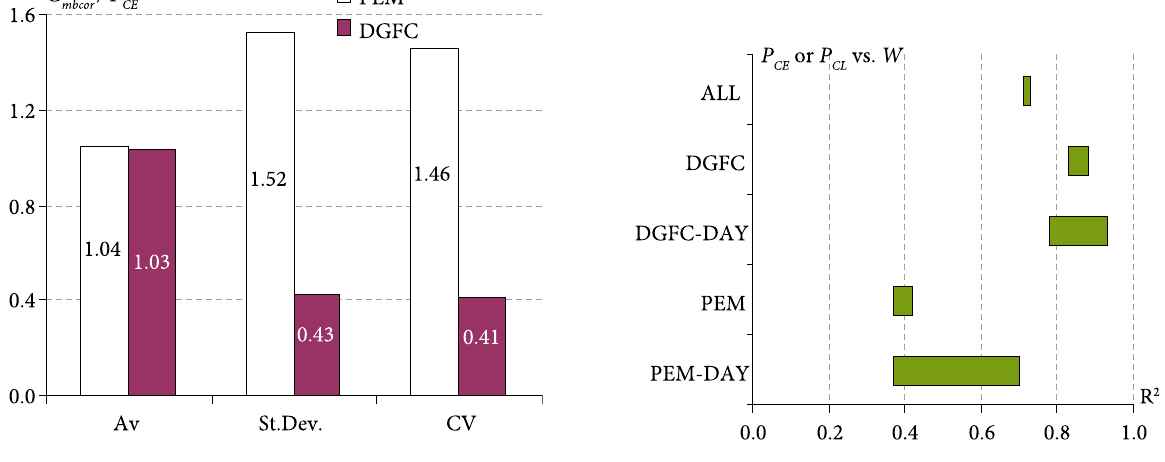
Fig. 2. R -square values of the correlations P J vs. G mbcor